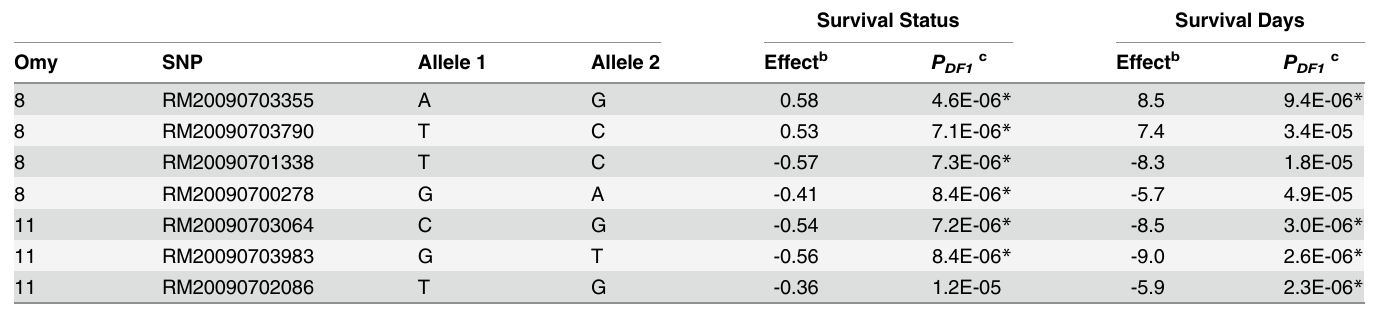
Table 1. GWAS summary: SNPs associated with BCWD resistance in rainbow trout family 2009070 a .